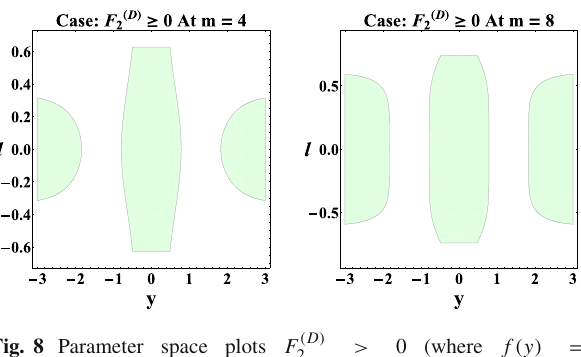
Fig. 8 Parameter space plots F ( D ) − log [ cosh ( y ) ] ) for m = 4 and 8